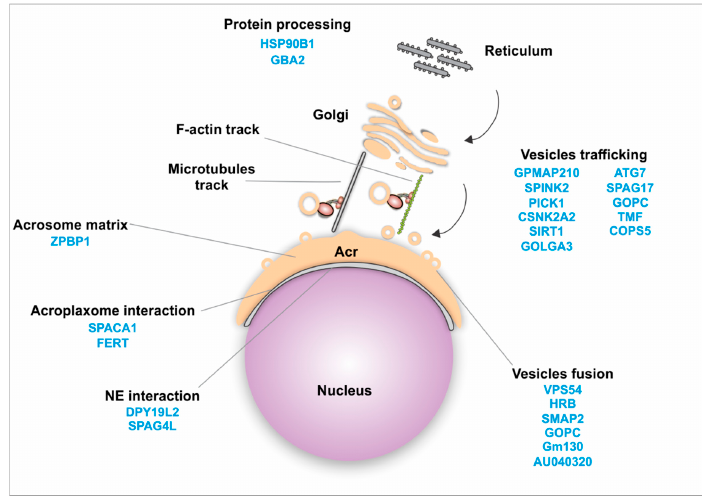
Figure 2. Schematic representation of the Golgi transport mechanism. Several proteins have been identified to play a role in acrosome biogenesis and vesicle transport. Golgi transport involves several steps including protein tra ffi cking from the reticulum to the Golgi apparatus, vesicle transport to the acrosome (Acr) via microtubules and F-actin tracks, vesicle fusion, interaction with the acroplaxome, interaction with the nuclear envelop (NE), and interaction with the acrosomal Table 3. List of proteins known to localize to the Golgi, Golgi vesicles, acrosome and/or acroplaxome, whose interacting partners were confirmed by immunoprecipitation (IP), co-immunoprecipitation (co-IP), yeast two-hybrid (Y2H) screen and/or IPA database (affinity chromatography, co-IP, anti-bait co-IP, enzyme activity assay, in situ proximity ligation assay, IP, liquid chromatography mass spectrometry, pulldown assay, tandem affinity purification, Western blotting, and yeast two-hybrid screen). Species were limited to human, mouse, and rat. Protein